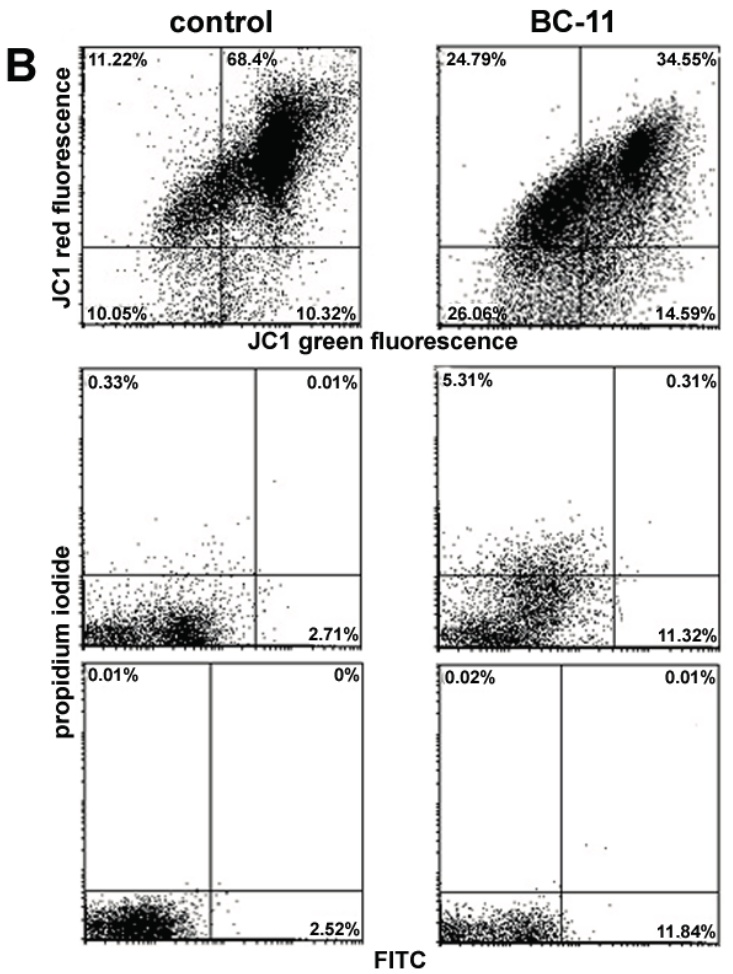
Figure 4. Effect of exposure of MDA-MB231 cells to BC-11 at its ED 75 at 72 h on cell cycle, mitochondrial activity and apoptosis promotion. ( A ) DNA profiles of MDA-MB231 cells after 72 h of culture in control conditions (lighter in the background) and in the presence of 250 μ M BC-11 (darker superimposed). Total cell distribution is reported in the annexed table; ( B ) Panel of flow cytometric assays of control cells and parallel cultures exposed to 250 μ M BC-11. Analysis of MMP through JC-1 staining is reported in the top dot plots where the percentages indicated in the bottom quadrants in each frame refer to low red-emitting cells that underwent dissipation of MMP. The middle dot plots report the result of the staining with two-colour ROS detection reagents. The percentage indicated in the quadrants in each frame refers to superoxide only overproducing cells (top left quadrant), total ROS overproducing cells (bottom right quadrant), and total ROS/superoxide overproducing cells (top right quadrant). Analysis of phosphatydilserine externalization through annexin V-FITC coupled to propidium iodide (PI) staining is reported in the bottom dot plots. The percentage indicated in the quadrants in each frame refers to necrotic annexin − /PI + and annexin + /PI + cells (both top quadrants) and apoptotic annexin + /PI − cells (bottom right